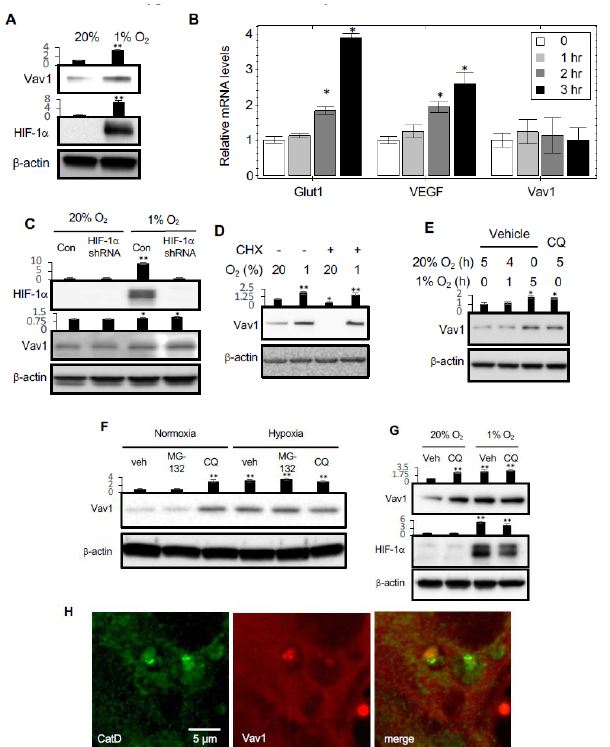
Figure 1. Hypoxia upregulates Vav1 through inhibition of lysosome-mediated protein degradation. ( A ) Human umbilical vein endothelial cells (HUVEC)s were cultured either in 20% or 1% O 2 for 5 h, followed by Western blot analysis for the indicated proteins. ( B ) qPCR analysis of Glut1, VEGF and Vav1 in HUVECs cultured in 1% O 2 for 0, 1, 2, or 3 hours. * p < 0.05 compared to corresponding time 0 in each group (mean ± SD). ( C ) The levels of Vav1 and HIF-1α were measured by Western blot of HUVECs transduced with HIF-1α or scramble shRNA expressing Lentivirus for 24h. ( D ) HUVECs